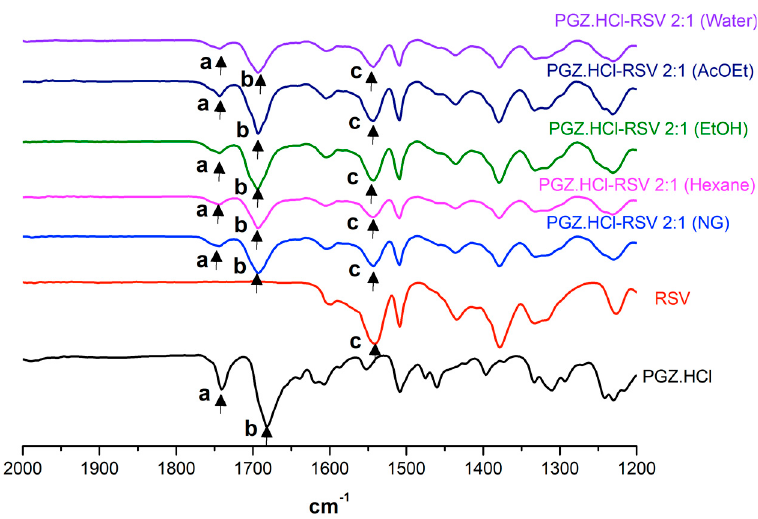
Figure 4. Expanded FT-IR spectra of the solid forms of PGZ · HCl-FLV (2:1) by NG or LAG solvent-screening. Table 2. Vibrational band assignment of the solid forms of PGZ · HCl-RSV (2:1) by NG or LAG solvent-screening.